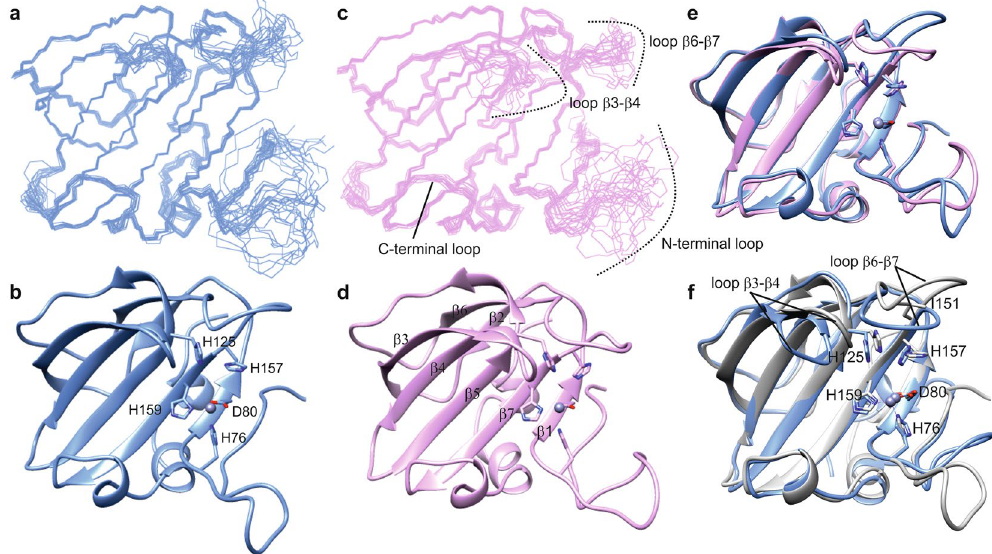
Figure 7. Structure of LytU and superposition to LytM catalytic domain. (a and c) Ensembles of fifteen structures of the least restraint violations of one- and two-zinc LytU, respectively. Backbone and heavy atom RMSDs for ordered residues of one- and two-zinc LytU are 0.3 and 0.7 Å, respectively. Residues shown are 57-192. (b and d) The lowest-energy structures represented in ribbon diagrams, for one- and two-zinc LytU, respectively. The substrate-binding groove can be seen horizontally, with the zinc-binding residues on the right. It is composed of four strands: β 1:79-82, β 3:95-103, β 4:107-114, β 5:119-129, and β 7:158-164 and four loops: N-terminal loop: 64-78, loops β 2- β 3:104-106 and β 6- β 7:147-157, and C-terminal loop: 165-171, the latter of which includes a 3 10 helical stretch. (e) Superposition of one- (blue) and two-zinc (pink) LytU. ( f ) Superposition of 1Zn LytU (blue) and LytM (PDB ID 2B13, grey). LytU is strikingly similar to LytM with an RMSD over backbone atoms in secondary structures of 0.9 Å. Residues shown are the zinc-coordinating H76, D80, H159 as well as the catalytic H125 and H157. The zinc ion is shown as a grey sphere. The position of the dimorphic residue of LytU, I151 in this case, is indicated in the β 6- β 7 loop. The structure of two-zinc LytU was determined with restraints for the first, tighter binding zinc only, and therefore the second zinc is not present in panels 2d and 2e. The figure was generated with the program UCSF Chimera 48